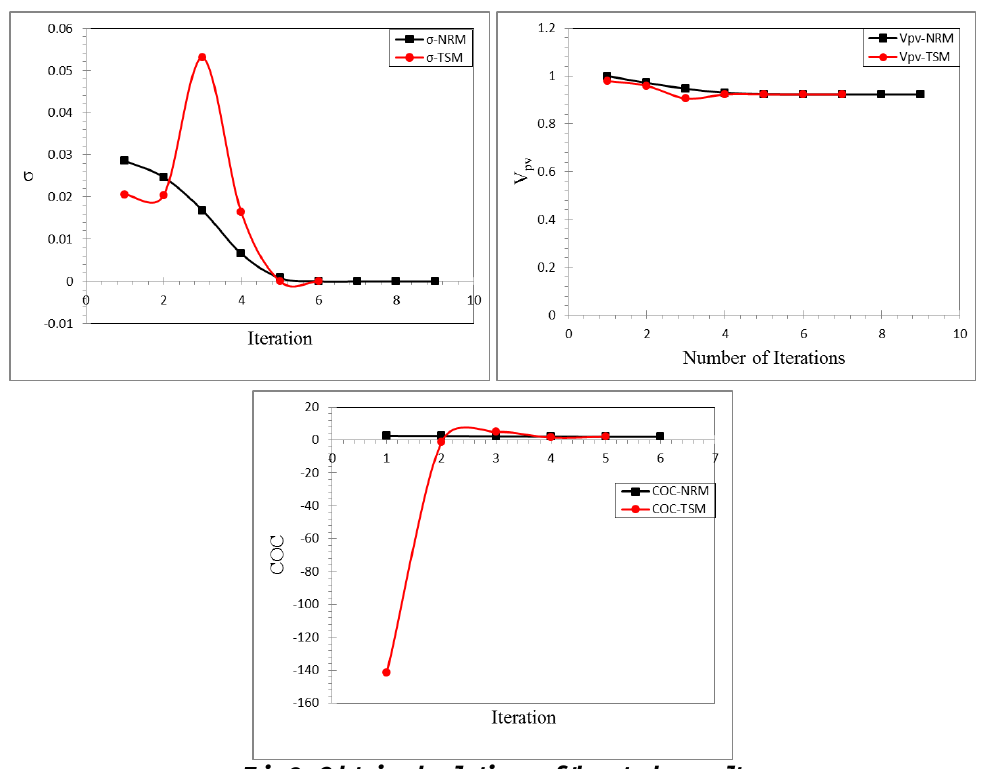
Fig.2: Obtained solutions of the study result.